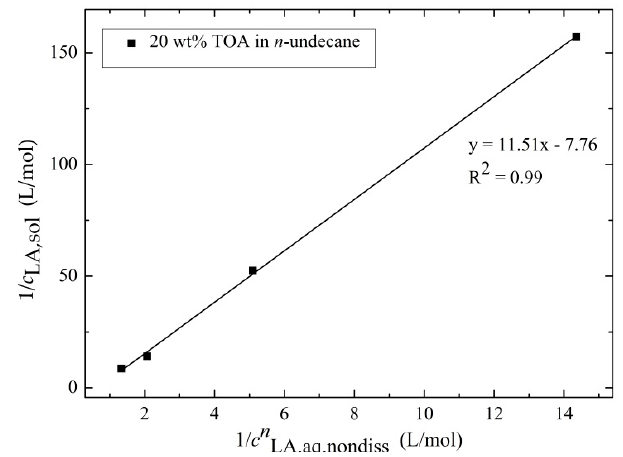
Figure 2. Determination of the extraction equilibrium constant and the degree of acid association of lactic acid (solvent with 20 wt% TOA in n -undecane; T = 25 °C; ambient pressure) according to Equation (10). ChemEngineering 2019 , 2 , x FOR PEER REVIEW